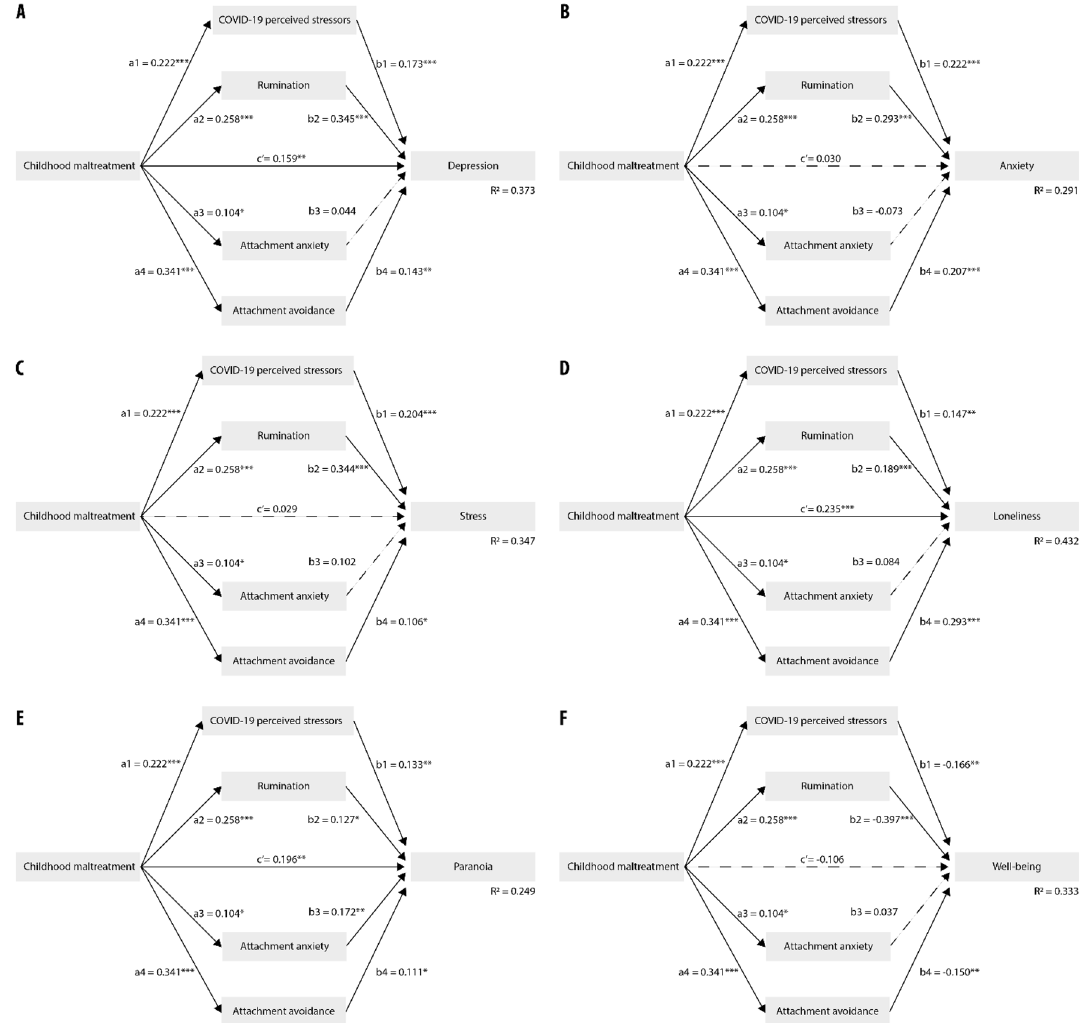
Non-significant paths are visualised using dashed lines. Regression coefficients are